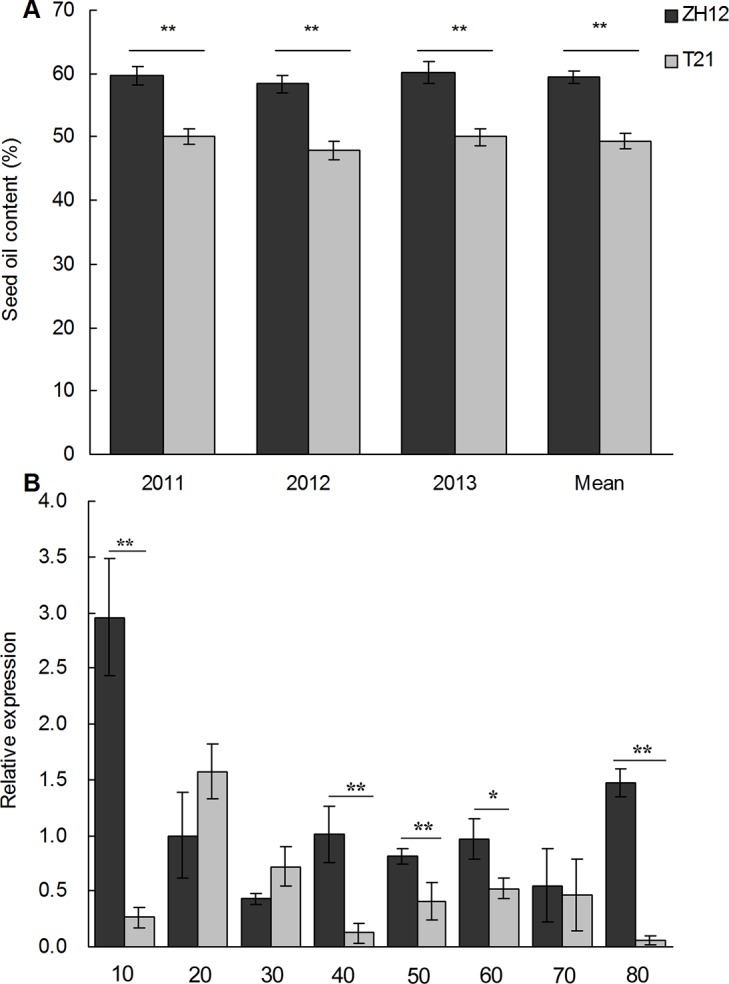
Phenotypic Variation in Seed Oil Content in High-Oil and Low-Oil Peanut Cultivars, Expression Pattern of AhLPAT2 in Eight Seed Developmental Stages of Them.A. Comparison of seed oil content from high-oil cultivar Zhonghua12 and low-oil Te21. Values are average seed oil content ± SE (n = 3). Asterisks indicate a significant difference between the compared pairs at p < 0.01. B. Transcript abundance of AhLPAT2 in different stages of developing peanut seeds. Total RNA was prepared from developing seeds of Zhonghua12 and Te21 at 10 to 80 DAF. qRT-PCR was performed to compare the overall transcript abundance of AhLPAT2 in Zhonghua12 and Te21. Gene expression levels are shown relative to the expression of peanut AhUbiquitin gene in each sample. Values are means ± SE (n = 3).Asterisks indicate significant differences between the wild-type and transgenic lines at p < 0.01 (**) and p < 0.05 (*).